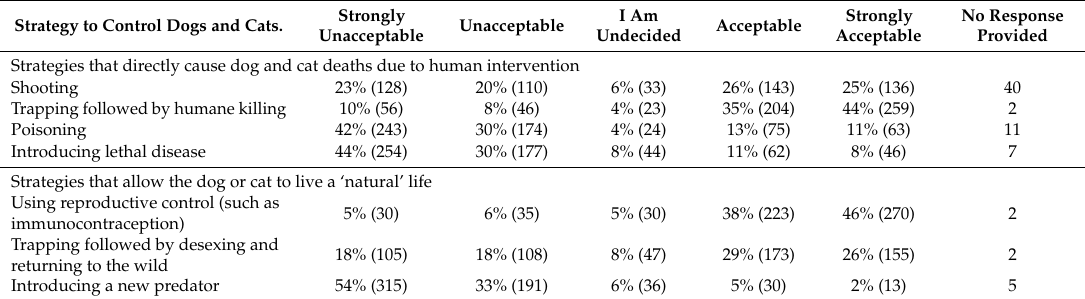
Table 3. Distributions (percentages 1 and numbers) of 590 respondents by views about the acceptability of various strategies for reducing or preventing wild dog and cat predation on wildlife. Strategy to Control Dogs and Cats.